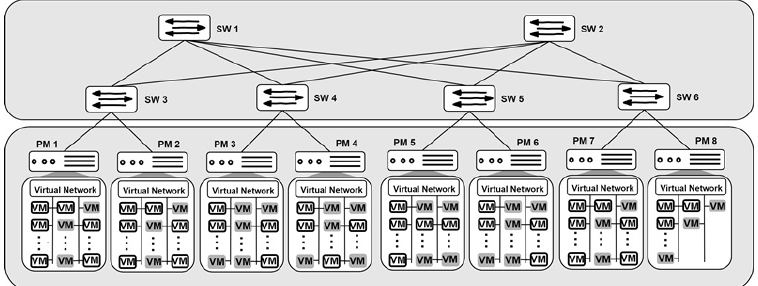
Figure 8. Large data center network topology with more VMs.